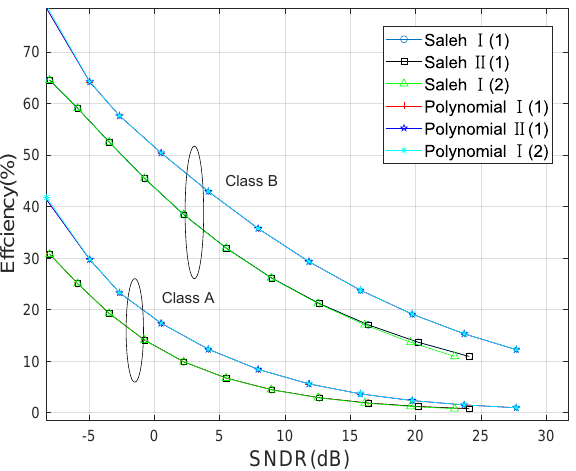
Figure 7. The tradeoff relationship between SNDR and PA efficiency ( P E / P I = 64 , Class A and Class B PAs, Saleh, and polynomial